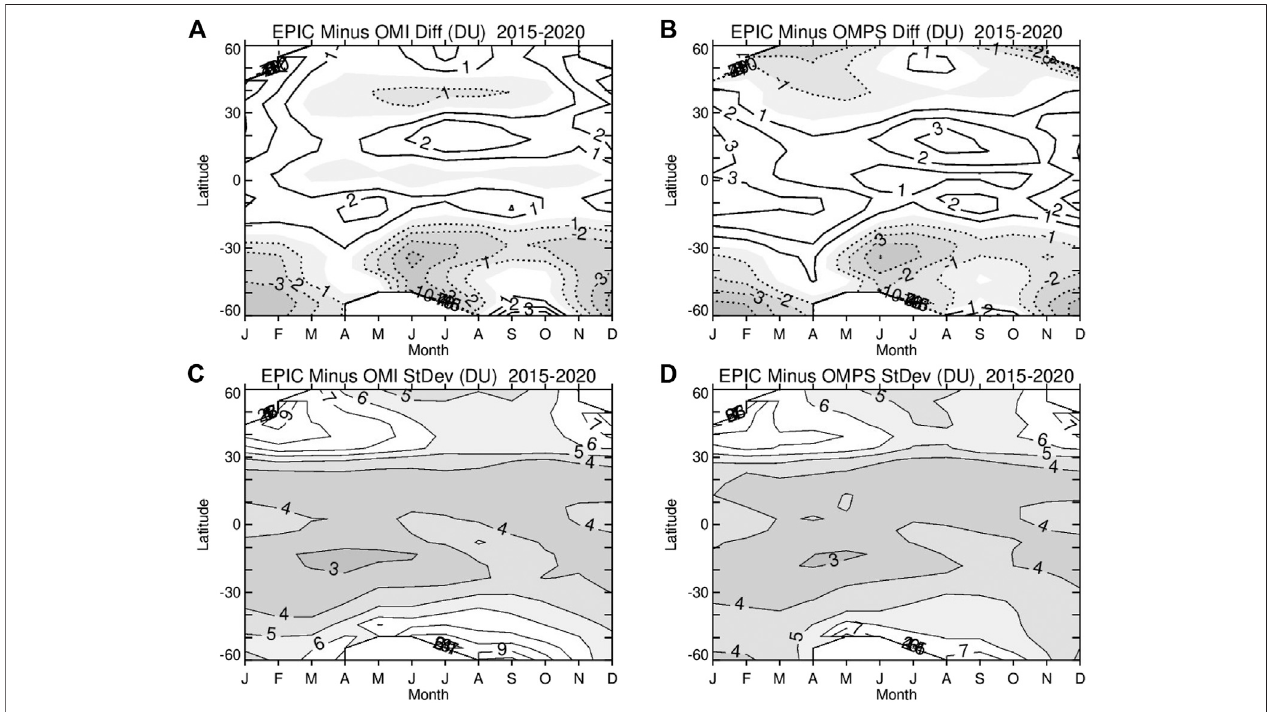
FIGURE 14 | Differences (in DU) between coincident EPIC TCO daily values and those from (A) OMI and (B) OMPS over the period between June 2015 and December 2020 shown as function of month and latitude. The positive differences are shown as solid lines in a-b, and negative as dashed lines and shaded. The corresponding 1-sigma standard deviations of the differences with OMI and OMPS are plotted as (C – D) , respectively.